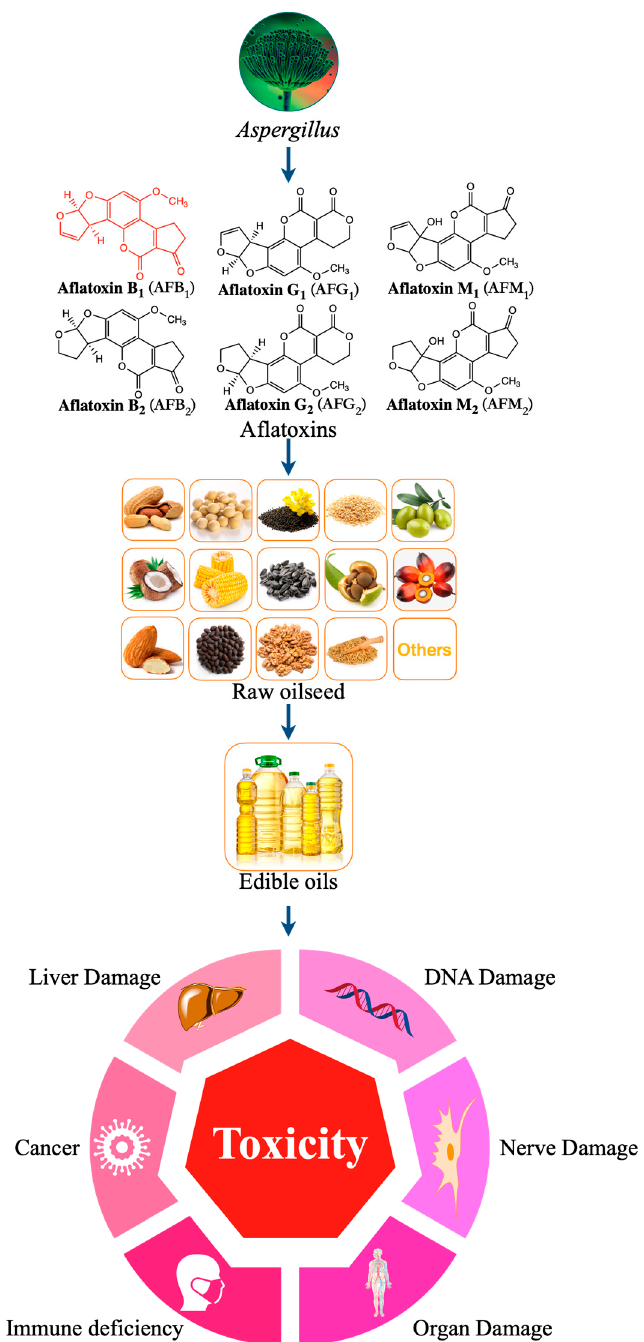
Figure 1. Harmful effects of different types aflatoxins contaminated edible oil.